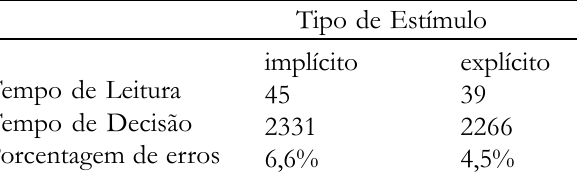
Tabela 1. Tempo de Leitura, Tempo de Decisão e Porcentagem de Erros nos Estímulos Explícitos e Implícitos